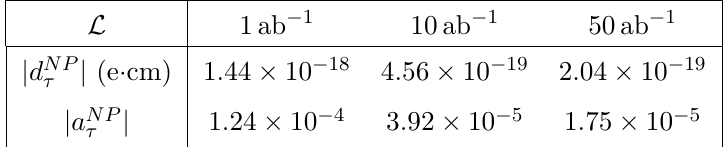
Table 3 . The 1- (cid:27) CL sensitivities to EDM and g -2 parameters for di(cid:11)erent integrated luminosities. To extrapolate from luminosity L 1 to L 2 , a factor of ( L 1 = L 2 ) 1 = 2 is applied. the results are not expected to be sensitive to higher-order corrections to the e + e (cid:0) ! (cid:28) + (cid:28) (cid:0) signal production cross